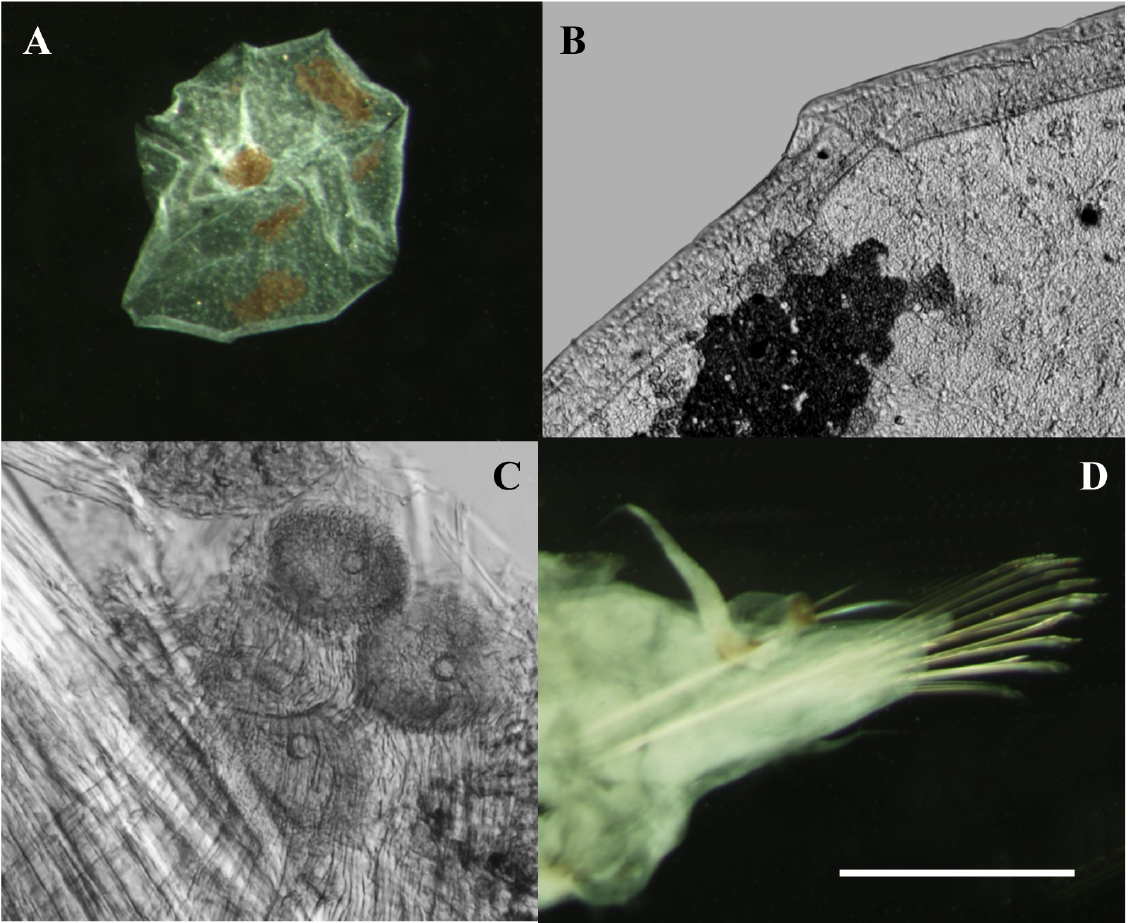
Fig. 4. Webbnesia maculata gen. et sp. nov., holotype (TFMCBM-AN/246). A . Left elytron of segment 21. B . Elytral margin with part of pigmented patch. C . Eggs within parapodium. D . Right cirrigerous parapodium of segment 20, with eggs in basal part. Scale bar: A = 1.6 mm; B–C = 200 µm; D = 0.5